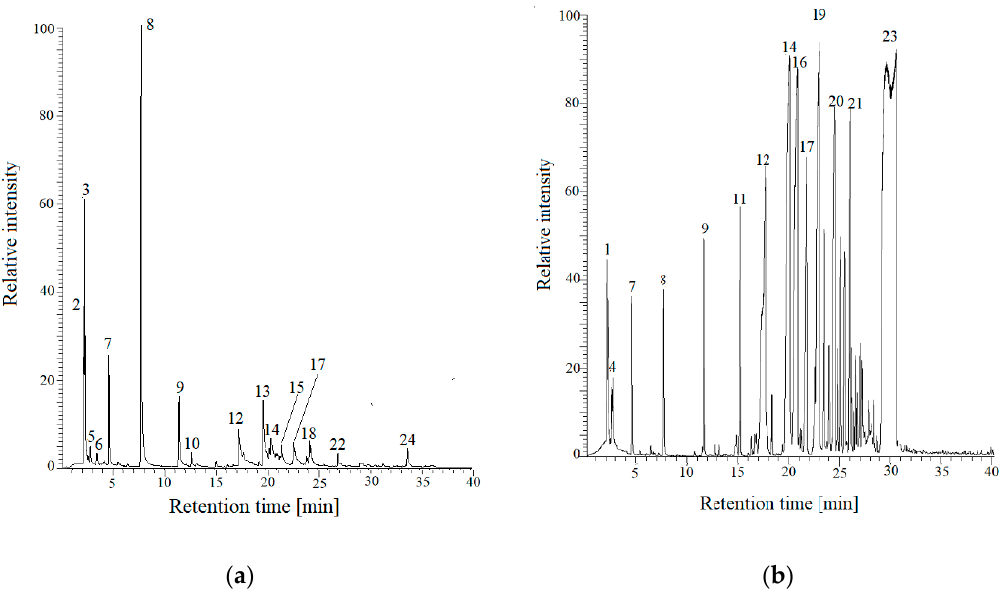
Figure 2. ( a ) Chromatogram obtained for the sample of furan resin (FNB) binder at the temperature of 1100 °C; and ( b ) chromatogram obtained for the sample of phenol-formaldehyde (PFNB) resin binder at the temperature of 1100 °C [31].